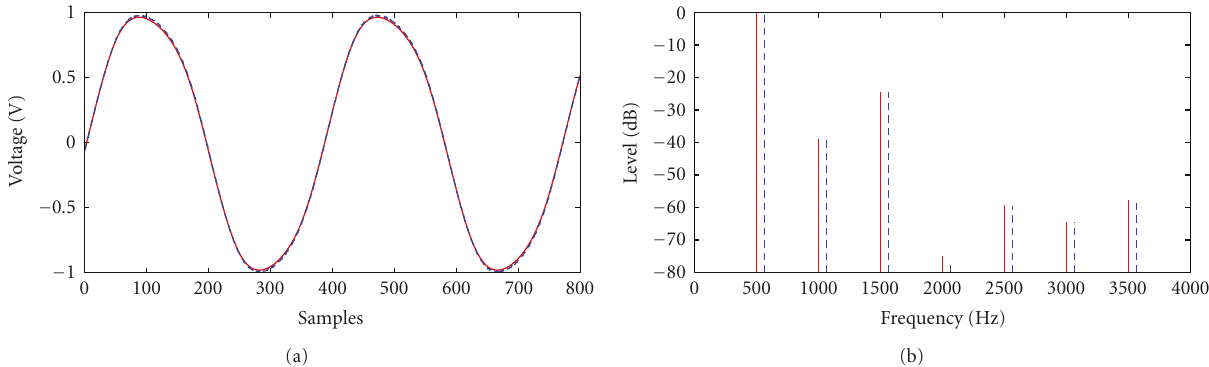
Figure 9: Comparison between the real-world output of pedal 2 (blue-dashed) and the GPH model-based output (red-solid) in time (a) and frequency (b) domains, for a sine wave excitation with f 0 = 500 Hz and A 0 = 1 V. The GPH model is estimated using a swept sine signal with amplitude A s = 1V. For the sake of clarity, the output of the real-world device in the frequency domain is shifted to the right.